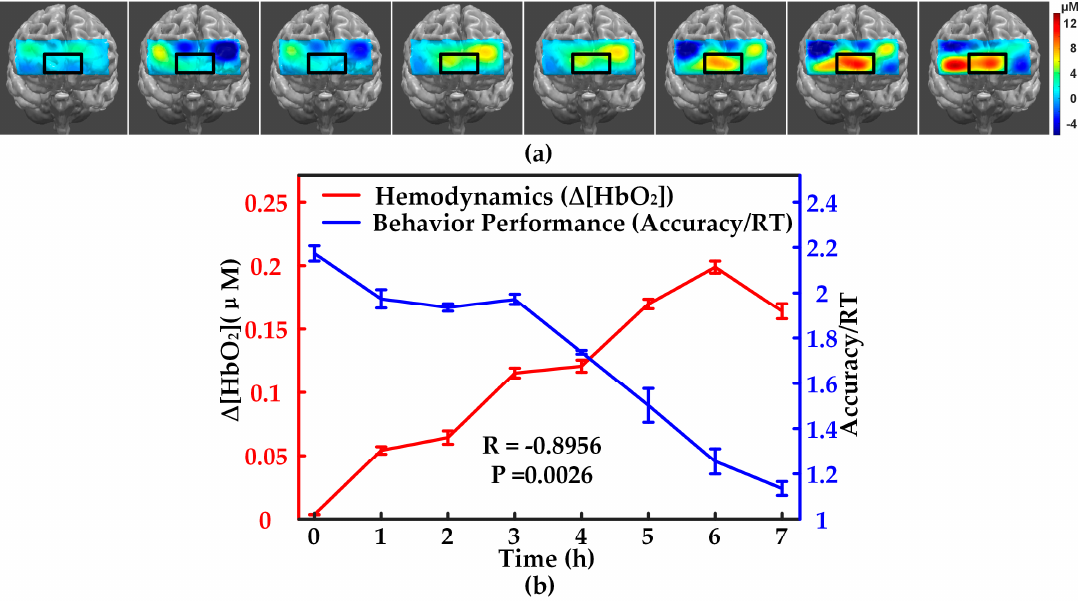
Figure 8. Fatigue measurements: ( a ) prefrontal activation map variation along with computer game duration; ( b ) ∆ [HbO 2 ] increment and behavioral performance factor along with computer game duration.